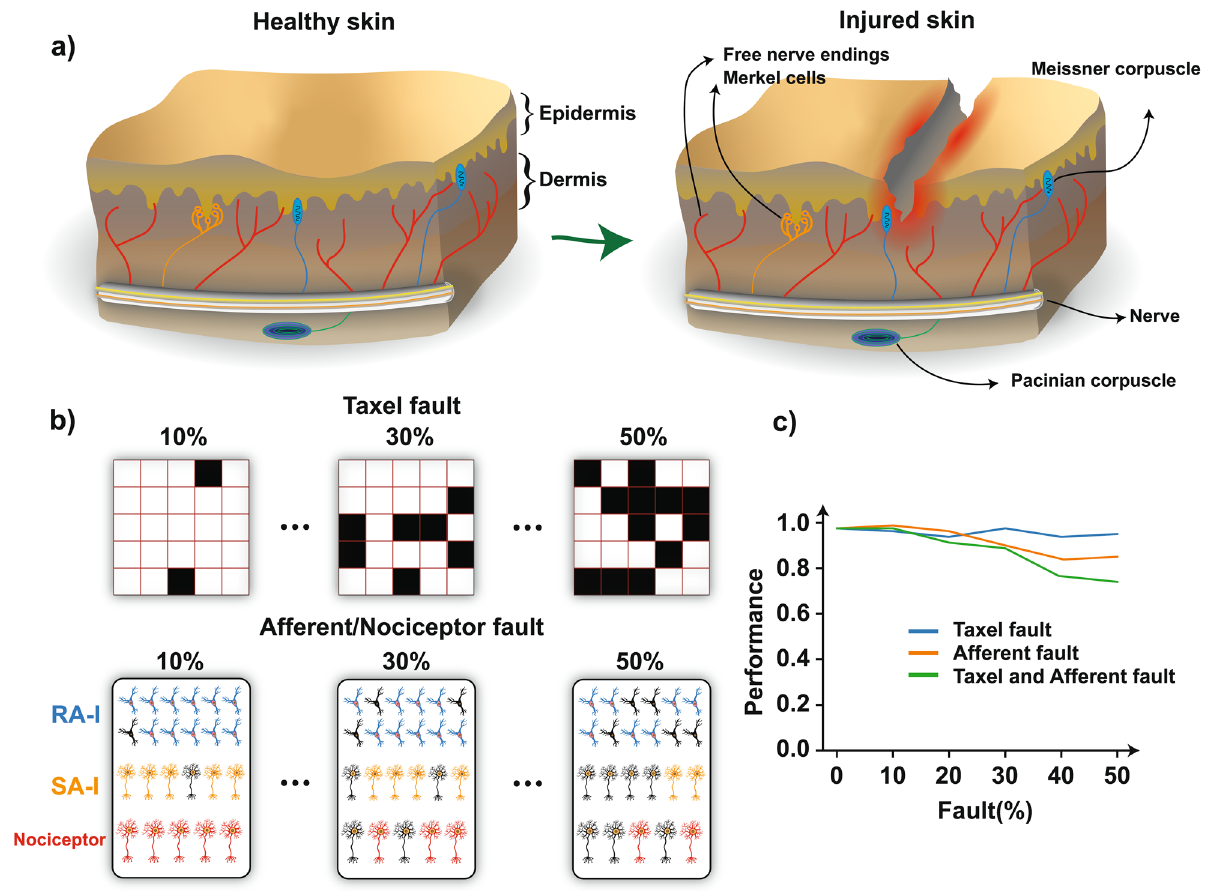
Figure 6. Robustness of the proposed bio-inspired system against taxel and afferent/nociceptor damage. ( a ) Schematic of the healthy and injured skin. ( b ) several taxels (top) and afferents (bottom) are randomly damaged (black squares and dark neurons, respectively). According to the fault level, the output signal of the damaged taxels is set to zero in the interface circuit (taxel fault experiment) or the digital neurons in the FPGA are deactivated and thus they cannot fire anymore (afferent/nociceptor fault experiment). ( c ) Classification performance for damaged taxels (blue), damaged neurons (orange), and both